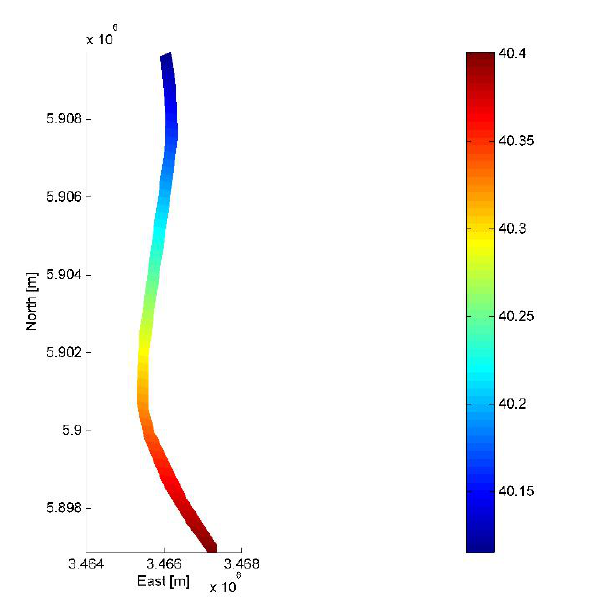
Figure 8: Not-to-scale plane surface fit for the GCG2011 geoid heights along the Weser River.